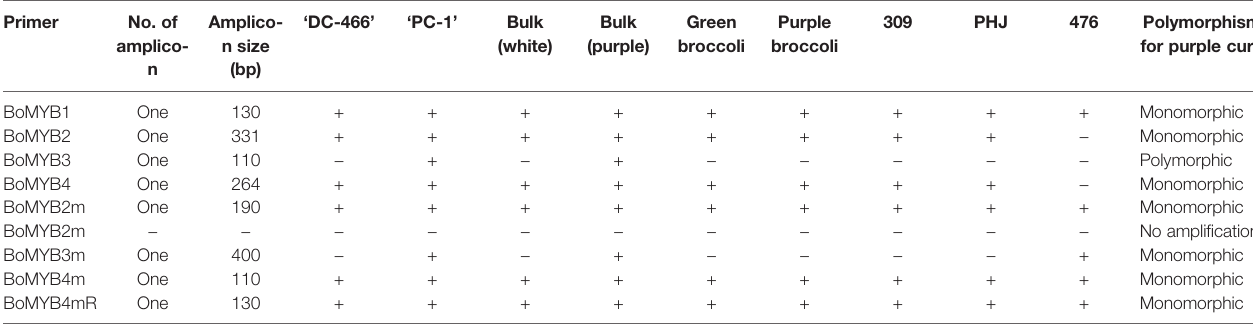
Amplicon present (+), absent ( −